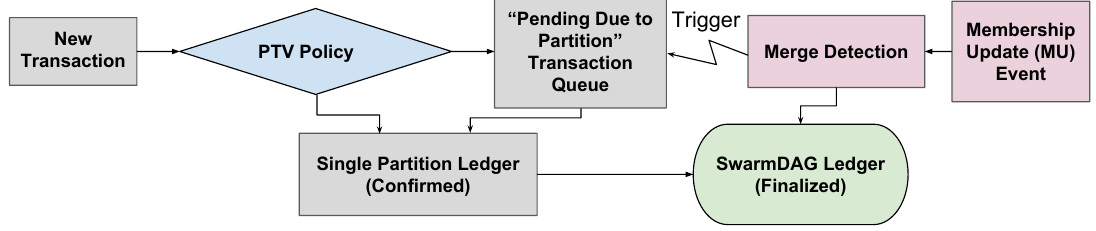
Fig. 2. Partition-Aware Transaction Verification (PTV)